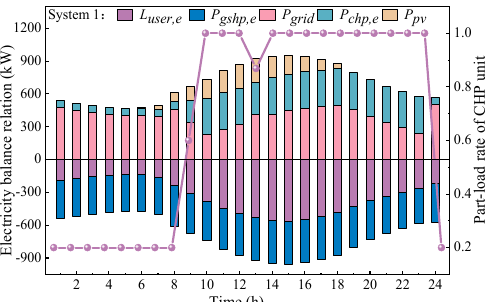
Figure 5. Cost differences between the three systems. Figure 6. Electric load supply − demand relationship and part-load rate of CHP unit in System 1.